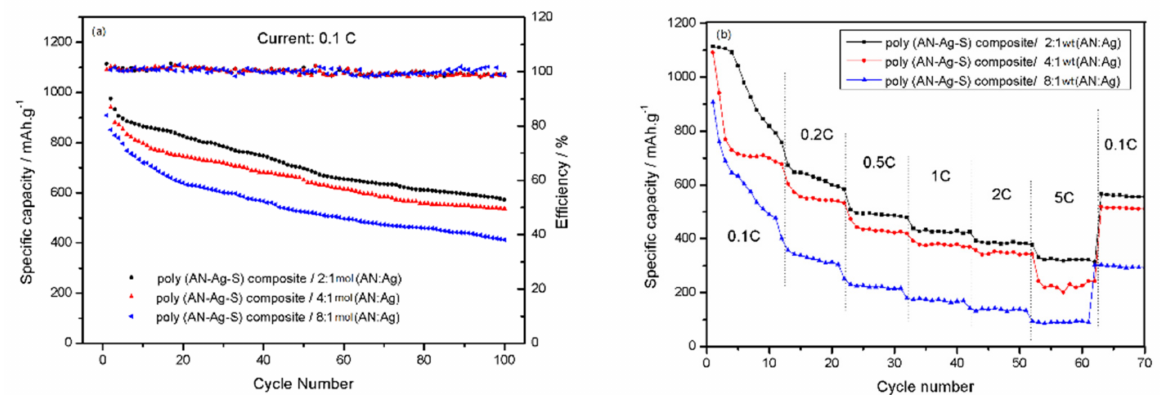
Figure 7. ( a ) The cycle performance and coulombic efficiency curves of poly (AN–Ag–S) composite/8:1 wt (AN: Ag), poly (AN–Ag–S) composite/4:1 wt (AN: Ag) and poly (AN–Ag–S) composite/2:1 wt (AN: Ag); ( b ) the rate performance curves of the poly (AN–Ag–S) composite/8:1 wt (AN: Ag), poly (AN–Ag–S) composite/4:1 wt (AN: Ag) and poly (AN–Ag–S) composite/2:1 wt (AN: